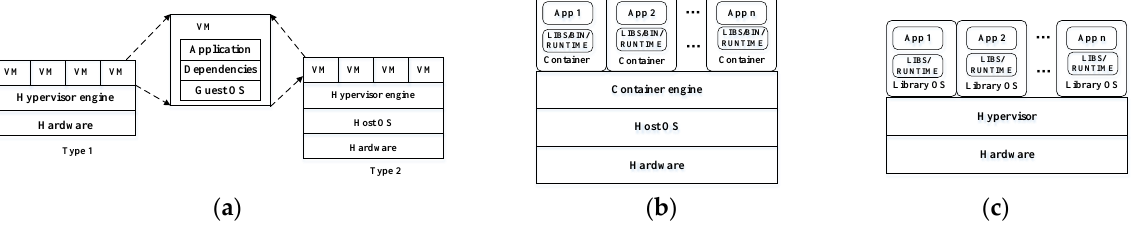
Figure 1. Virtualization Architectures: ( a ) Virtual machines; ( b ) Container; an ( c ) Unikernel. Table 5. Comparison among VM, Container and Unikernel.